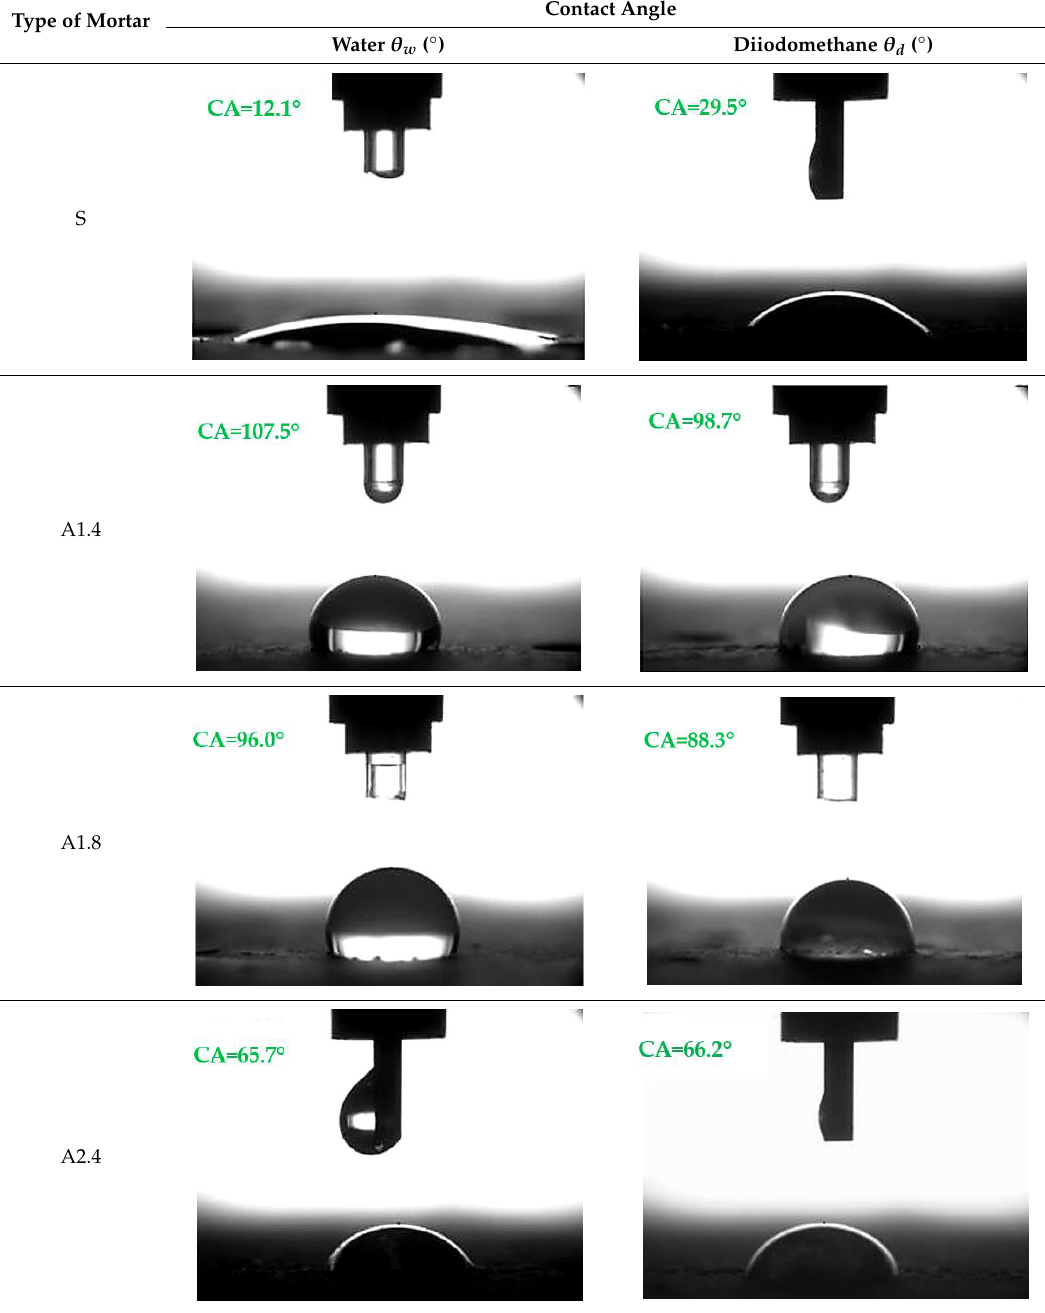
Table 7. Angles of liquids of standard and hydrophobized mortars.